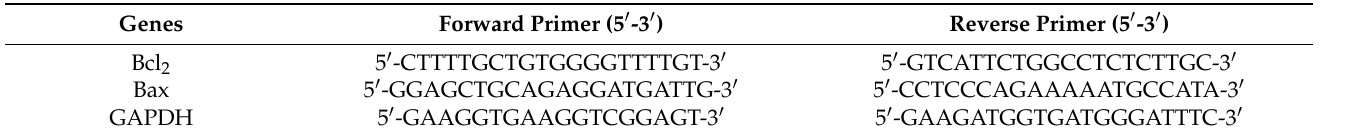
Table 1. Forward and Reverse primers of apoptotic genes used for